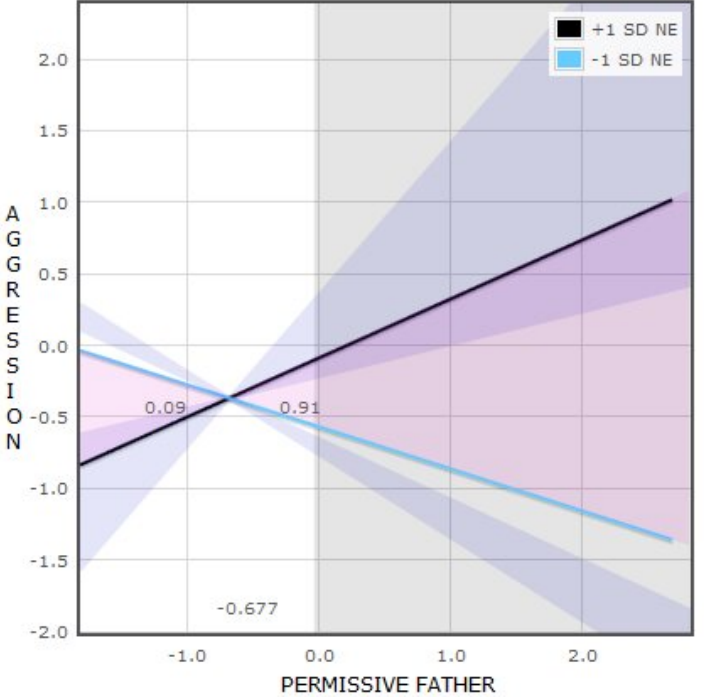
Figure 2. Interaction between negative emotionality and permissive father in relation to aggressive behavior in girls. Table 5. Regression analysis for aggressive behavior including permissive father and negative emo- tionality.